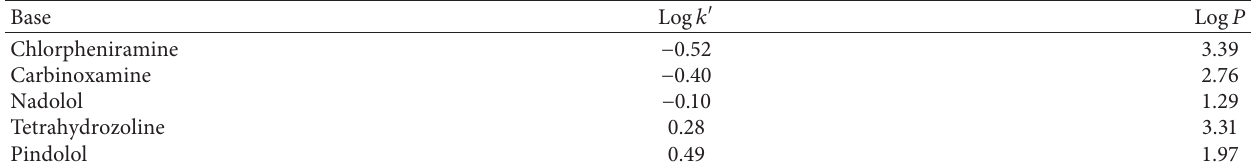
Table 5: Hansch hydrophobicity parameters and nitrogen-containing compounds retention factors on